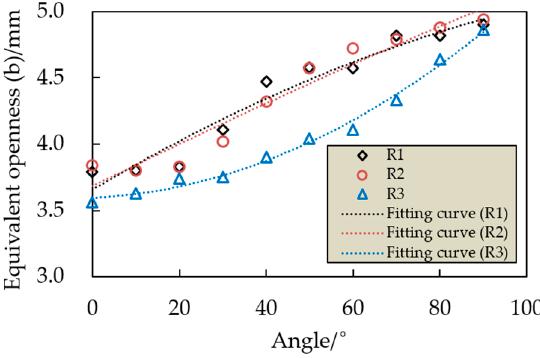
Figure 16. Equivalent openness in all directions under different test conditions.